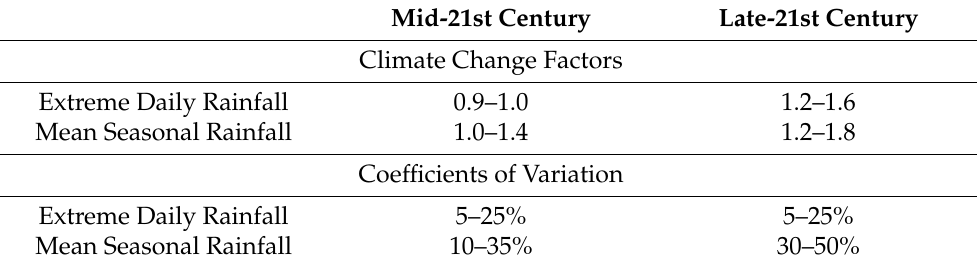
Table 6. Climate change projections over Wanzhou